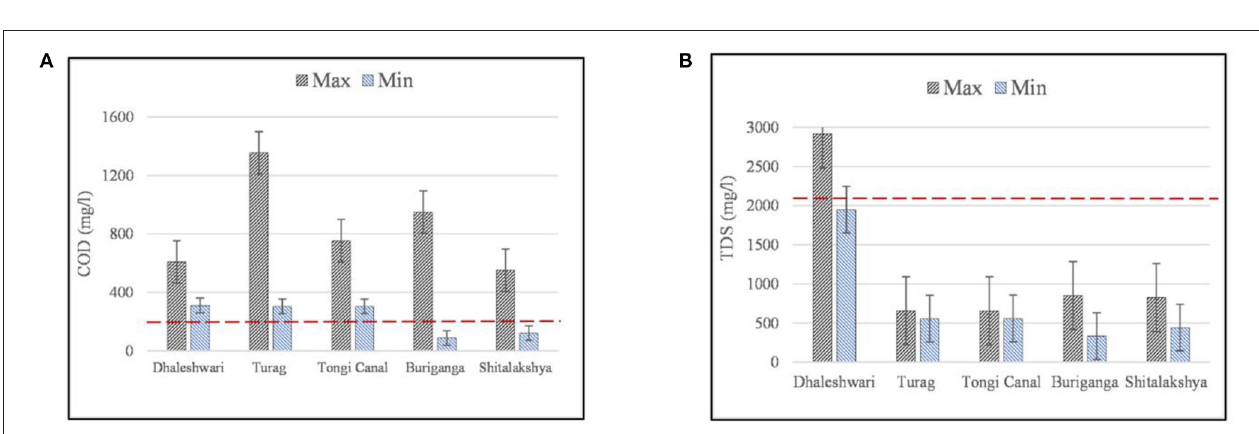
Dhaleshwari River water varied from 1,948 to 2,914 mg/L, with the highest level found at outfall D-1 (Savar Tannery) and the lowest level recorded at outfall D-2 (Sudkhira) ( Figure 3B ).